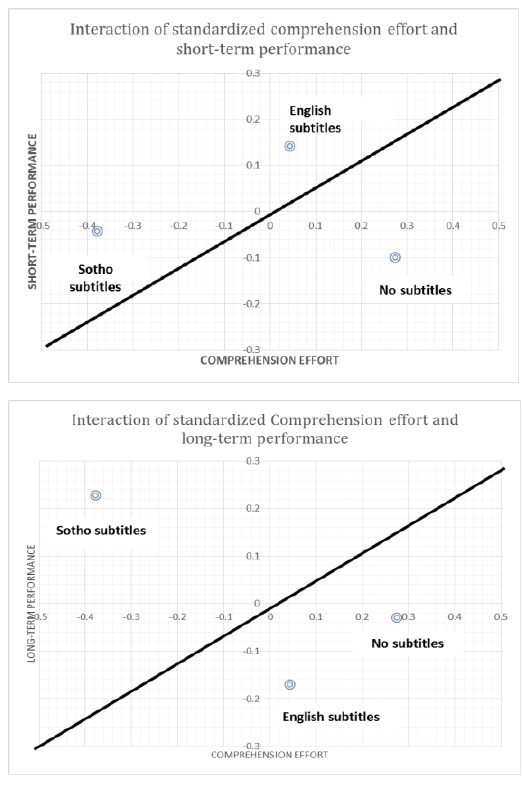
Figure 6, the position above the diagonal efficiency line indicates positive efficiency, while positions below the line indicate negative efficiency.